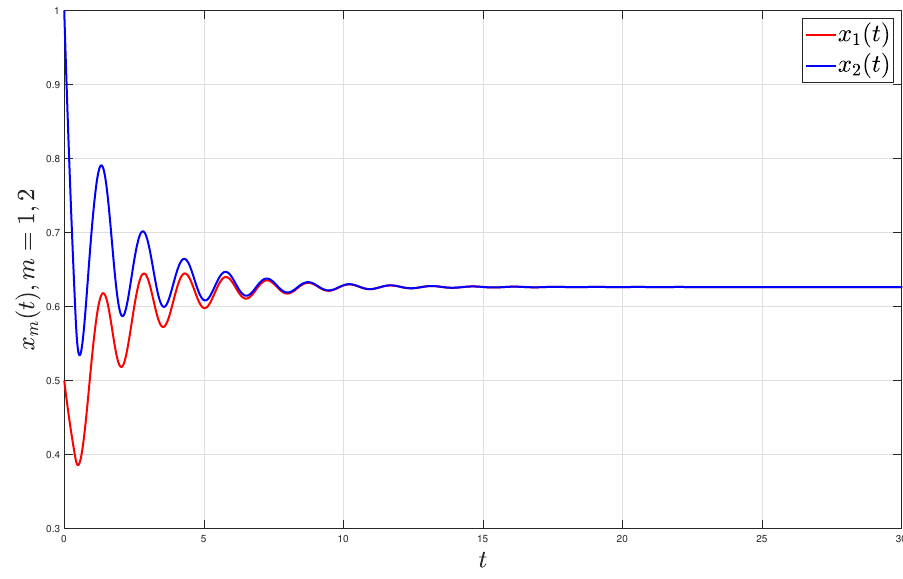
Figure 1. Waveform diagram with 0.4 = τ < τ ∗ = 0.5303, the system is stable.